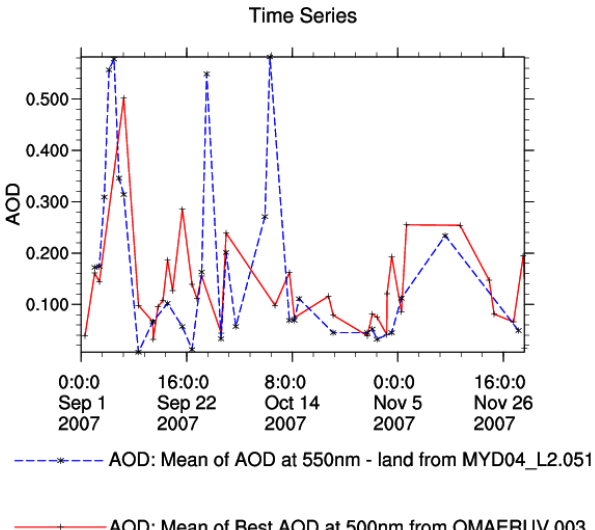
Fig. 7. A time series plot comparing means of MODIS and OMI AOD at GSFC, produced by Web MAPSS for the parameters shown in Fig. 6. Note that this is just an illustration of the Web MAPSS graphic output, and not to be considered as a fair comparison, as the Aqua-MODIS data shown on this plot reports AOD at 550nm, whereas Aura-OMI AOD measurements are reported at 500nm.